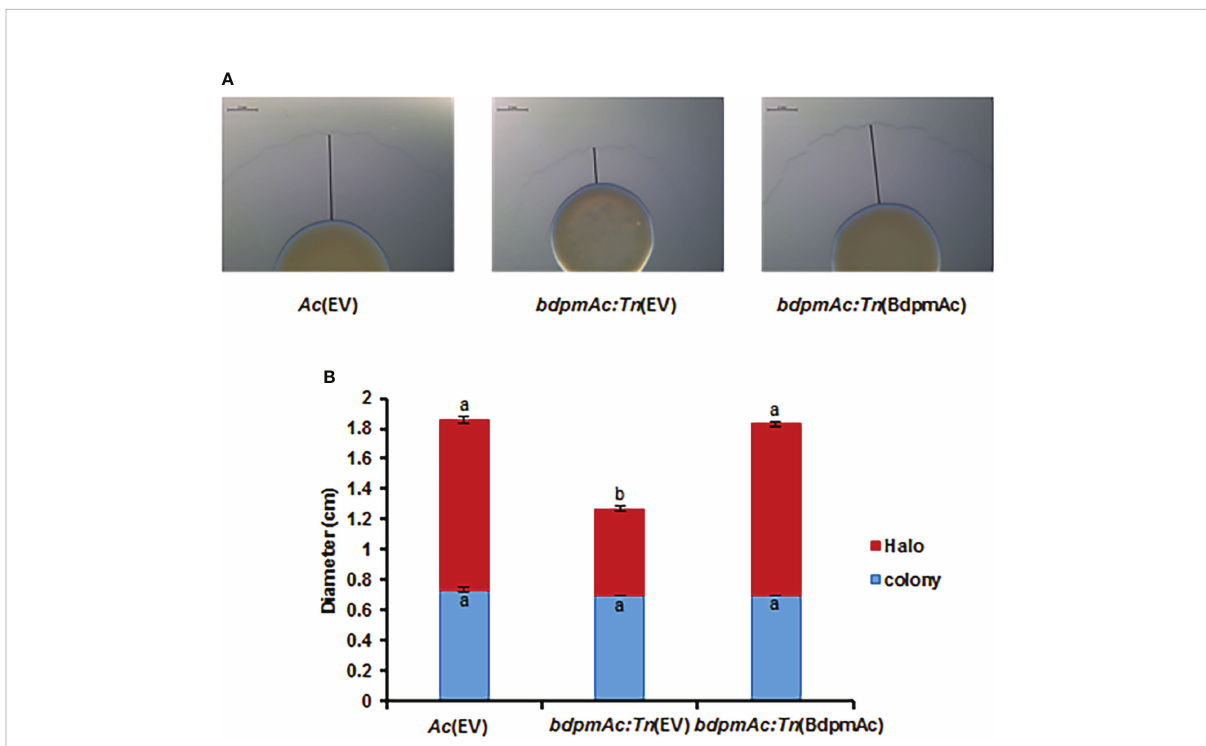
FIGURE 5 Twitching halo size in Ac (EV), bdpmAc:Tn (EV), and bdpmAc:Tn (BdpmAc). (A) Observation of twitching halo size under a stereoscopic microscope. The black lines indicate the length of the twitching halo. Scale bar: 2 mm. (B) Measurement of the colony and twitching halo sizes. The blue and red bars indicate the diameter of the colony and twitching halo diameter, respectively. The error bars indicate the standard deviations of three biological replicates. Different characters indicate signi fi cant differences according to ANOVA (p<0.05) with Tukey ’ s HSD test. Eight independent experiments were carried out, all of which exhibited similar